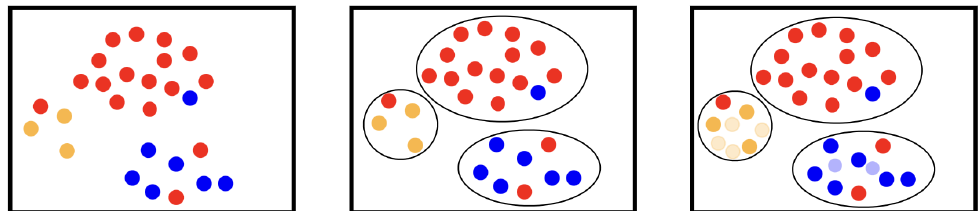
Figure 21. Toy example of the K-Means SMOTE algorithm. The left image shows the toy dataset, which consists of 3 classes: the blue and the orange are minority classes, and the red one is a majority class. The creation of clusters took place at the center. In the right picture, the clusters with a high proportion of samples from the minority class were populated with synthetic